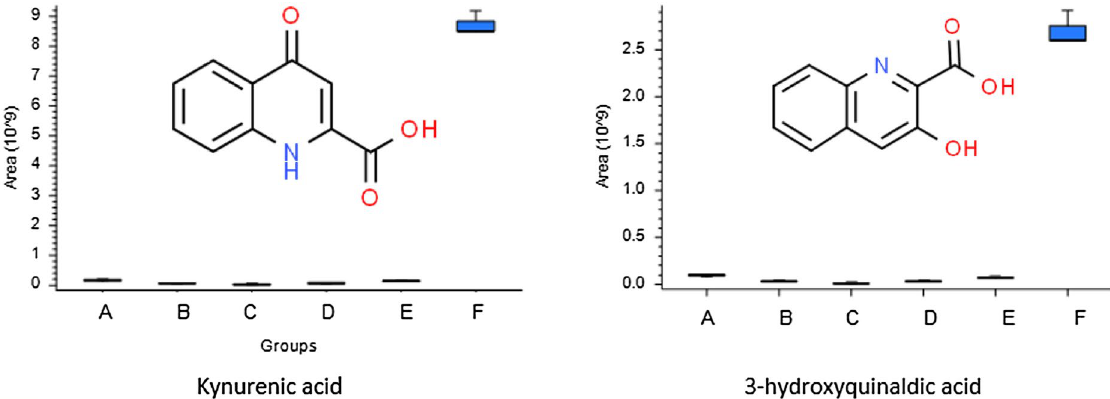
Figure 4. Kinurenic acid and 3-hydroxyquinaldic acid structure and content in the six honey samples, performed in triplicate. The box diagram representing the median with distribution interval between 25 and